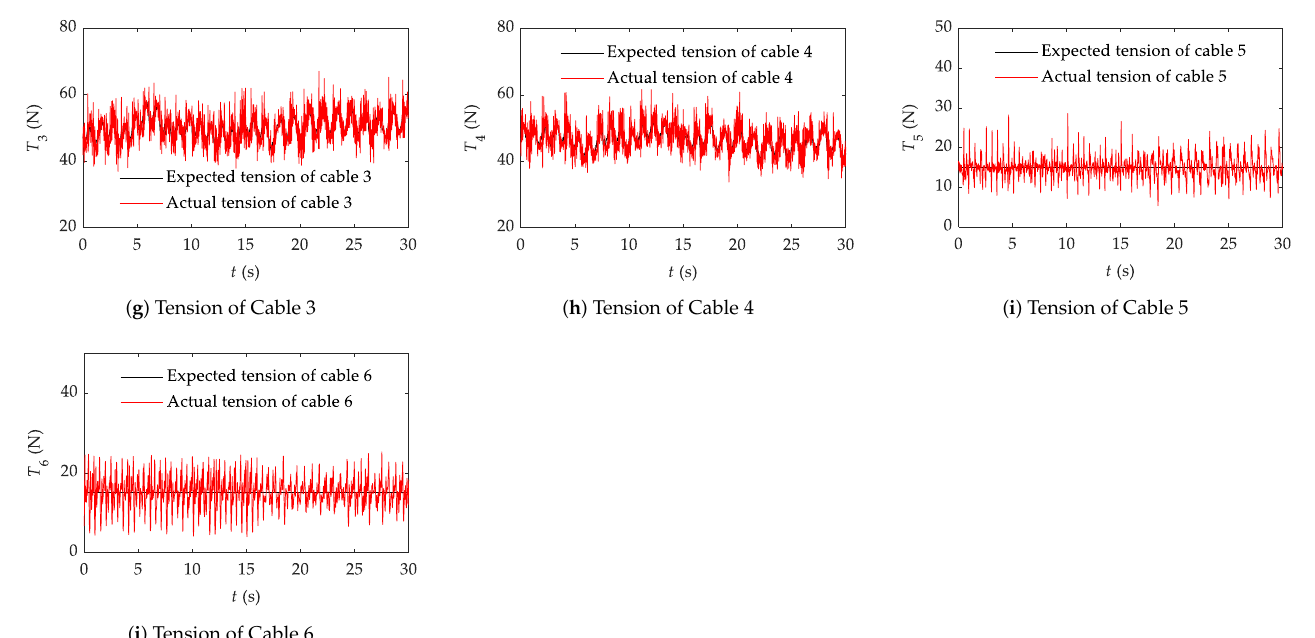
Figure 15. Running experiment results. ( a ) Track of load point; ( b ) Offset of load point; ( c ) Load force F z ; ( d ) Load force in x and y directions; ( e ) Tension of Cable 1; ( f ) Tension of Cable 2; ( g ) Tension of Cable 3; ( h ) Tension of Cable 4; ( i ) Tension of Cable 5; ( j ) Tension of Cable